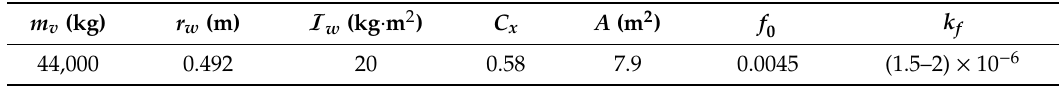
Table 6. Parameters of the model of vehicle dynamics.